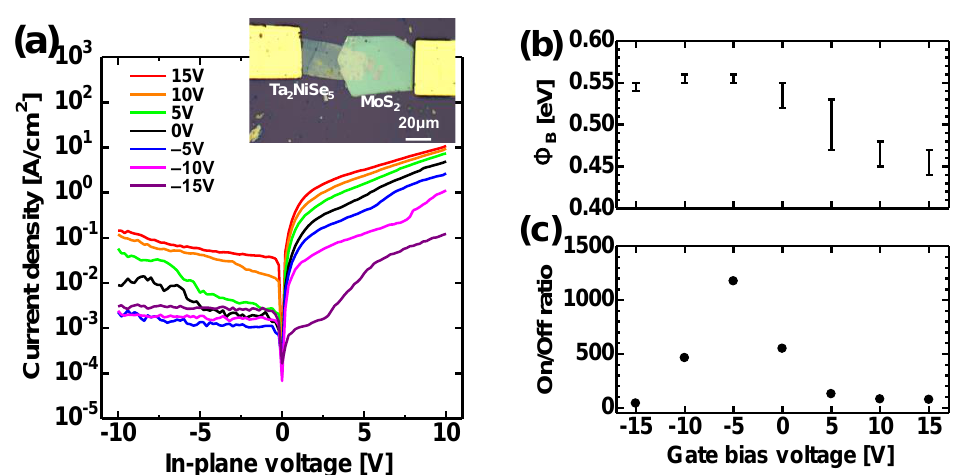
Figure 4. ( a ) J - V characteristics of the MoS 2 /Ta 2 NiSe 5 heterojunction depending on gate bias voltage; ( b ) barrier height at the MoS 2 /Ta 2 NiSe 5 heterointerface; and ( c ) rectification ratio depending on gate bias voltage.